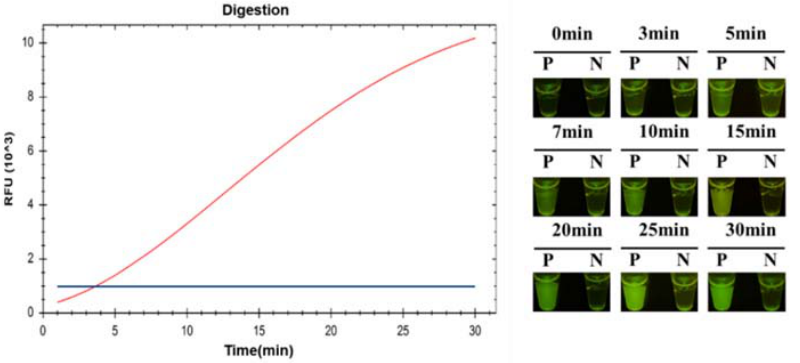
Figure 7. The time evaluation ICB-LAMP-CRISPR/Cas12a. A total of 1 mL 8 × 10 3 CFU/mL C. jejuni was detected by the ICB-LAMP-CRISPR/Cas12a method, and monitored by a CFX96 Touch Time PCR Detection System and real-time photograph detection for 30 min.